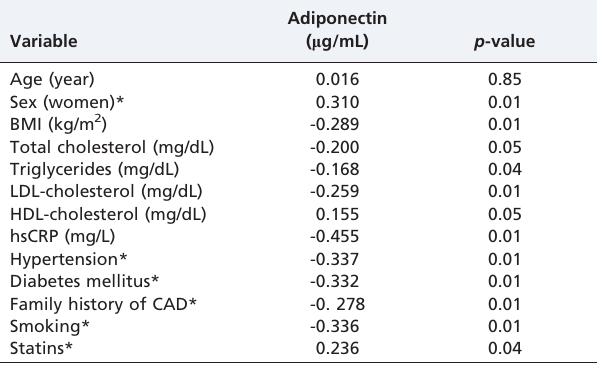
Table 2 - Bivariate correlations between conventional clinical risk factors and adiponectin